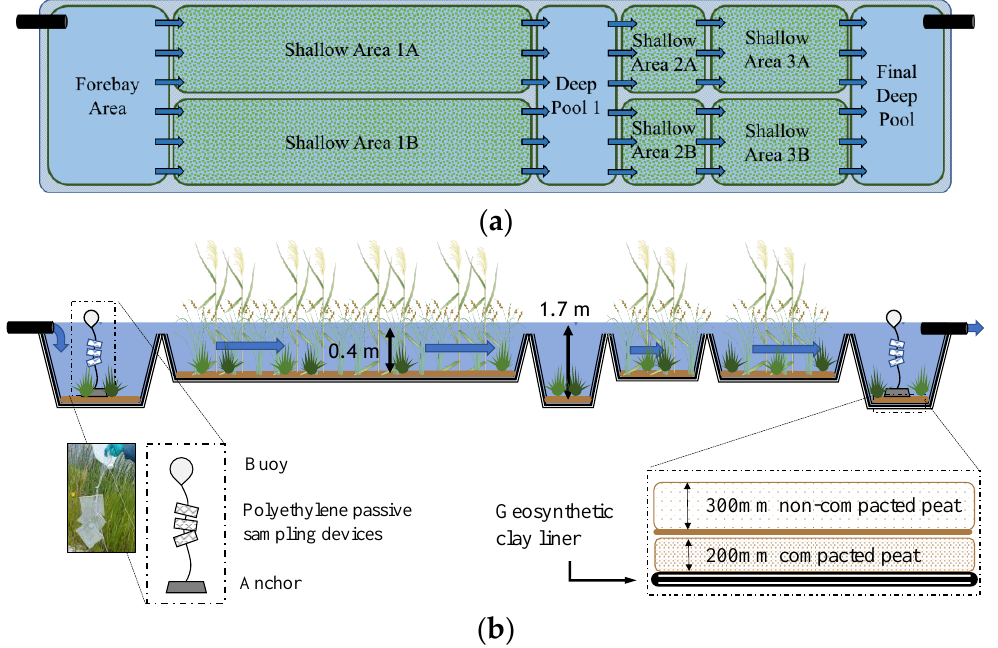
Figure 1. Schematic diagram of the Kearl Treatment Wetland showing ( a ) planar view, and ( b ) cross-sectional view with the passive sampling devices and rooting medium. Photo shows polyethylene passive samplers in aluminium mesh casings connected to buoys.